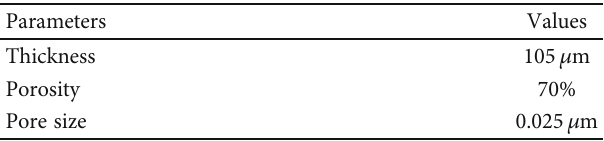
Table 1: Speci fi cations of graphene oxide.